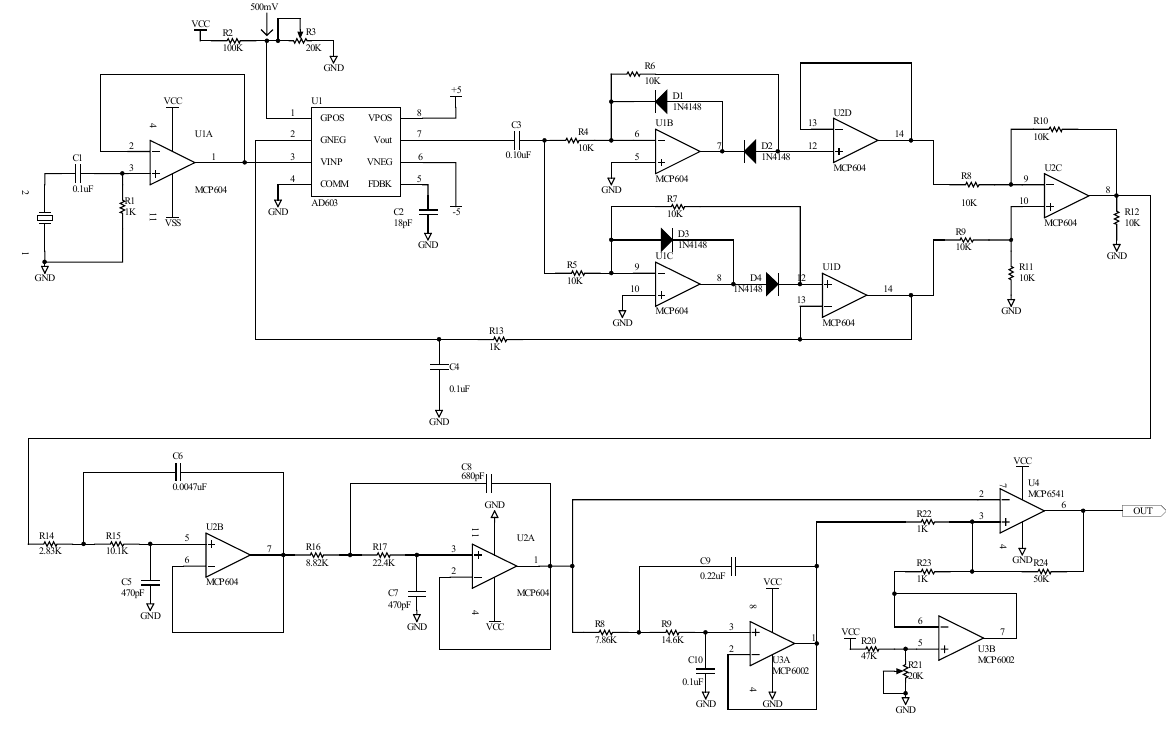
Figure 8b. The receiver circuit that processes the received signals from the transducer to digital information readable by the main